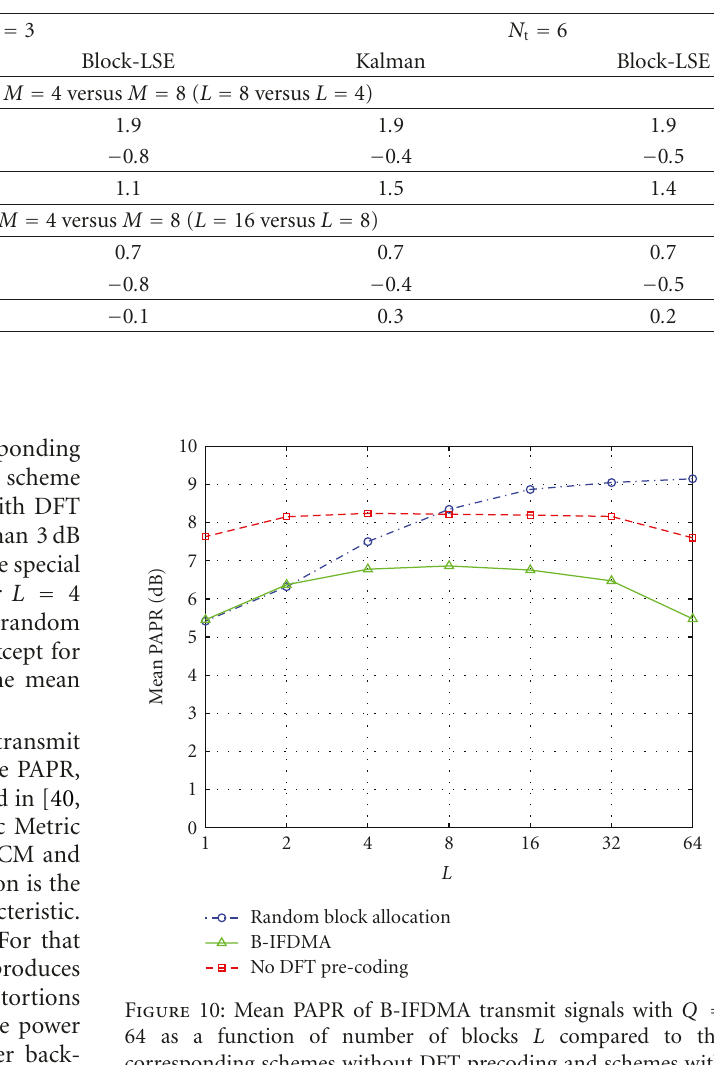
Table 2: Overall performance comparison of SISO B-IFDMA with Q = 32 or Q = 64 subcarriers per user and M = 4 or M = 8 subcarriers per block with N = 1024 subcarriers in the system.